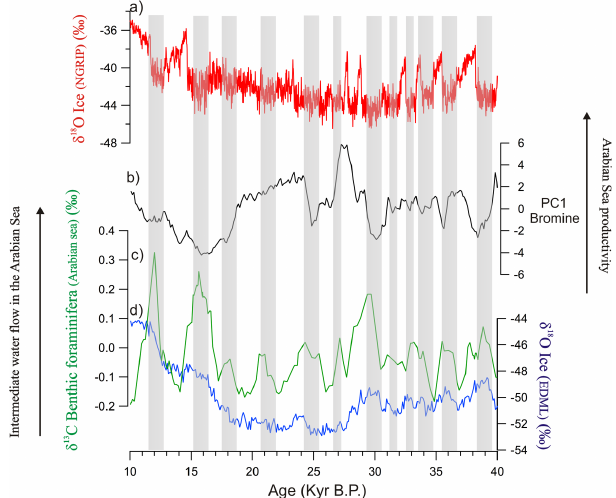
Fig. 5. Comparison between Indian summer monsoon (ISM) changes, intermediate water circulation changes and bipolar climate variability over the period 10–40kyr. (a) NGRIP δ 18 O ice record from Greenland (NGRIP members, 2004). (b) PC1-bromine as a proxy for ISM. (c) δ 13 C as a proxy for intermediate water circu- lation changes in the Arabian Sea (Jung et al., 2009). (d) EPICA Dronning Maud Land (EDML) δ 18 O ice record from Antarctica (EPICA community members, 2006). Grey bars indicate increase of intermediate water flow in phase with decrease of productivity in the Arabian Sea.